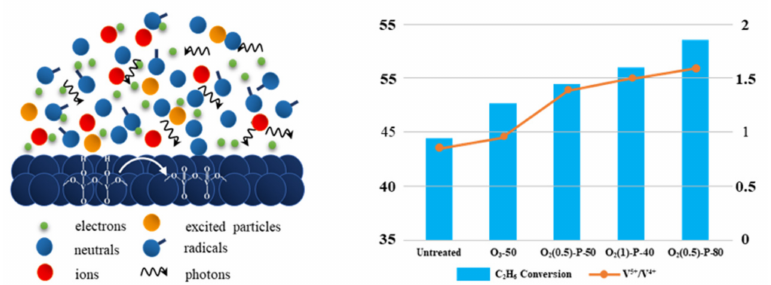
Figure 16. The variation of the abundance V 5+ content of MoVNbTeO x catalysts by non-thermal plasma treatment was correlated with the catalytic performance. Adapted from ref. [19], Copyright (2015), with permission from the Royal Society of